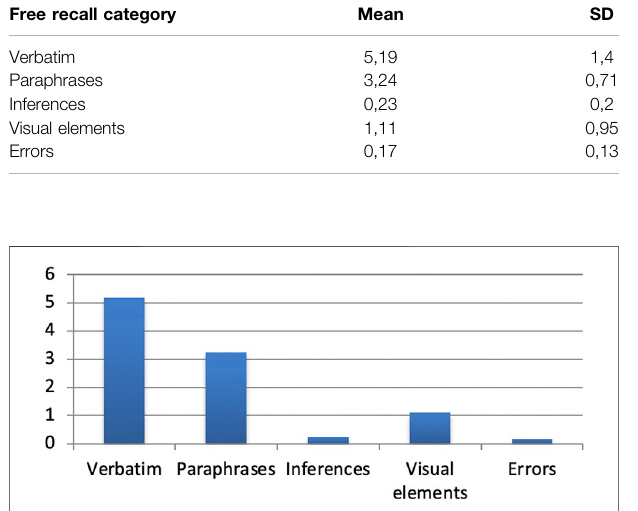
FIGURE 5 | Mean number of free recall per category.